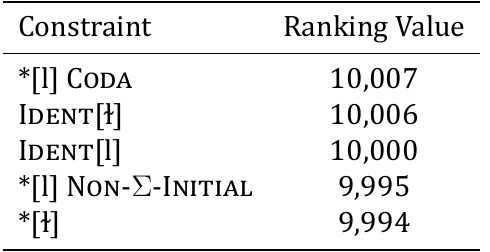
Table 13: Constraint ranking values at the phrase level